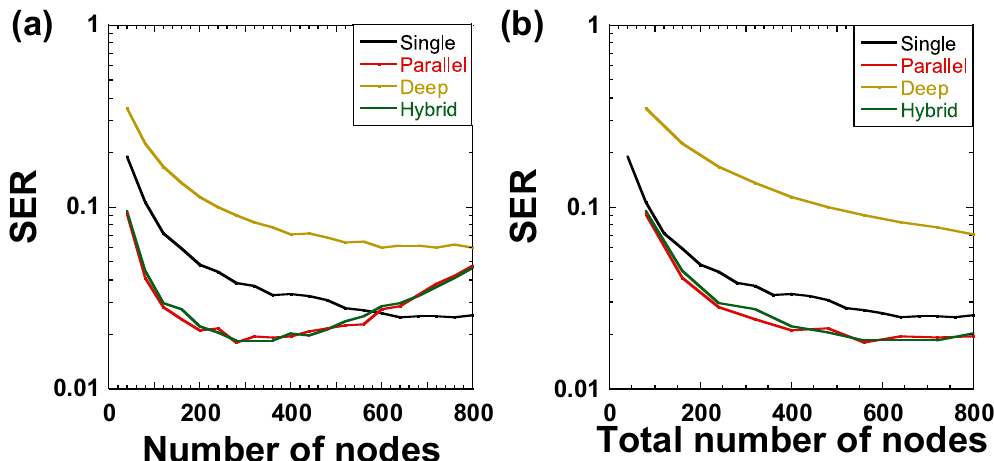
Figure 5: Symbol error rate (SER) of the nonlinear channel equalization task as a function of (a) number of nodes N for each reservoir and (b) for all reservoirs for single (black), parallel (red), deep (brown), and hybrid (green) configurations. (a) N the total number of nodes N total N for the single configuration and 2 N for parallel, deep, and hybrid configurations. (b) N total is matched to N for all four